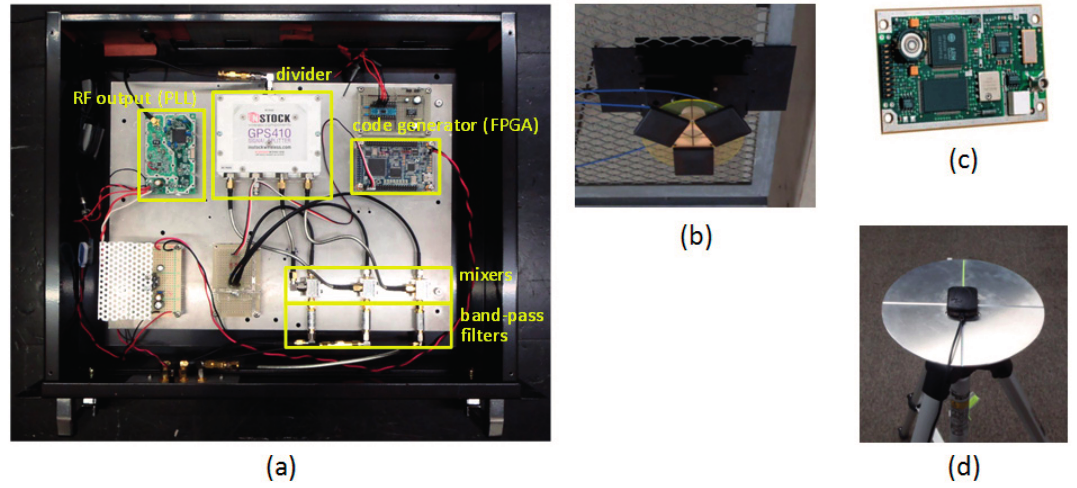
Figure 3. ( a ) Multi-channel pseudolite (three channels); ( b ) Three channel antenna array; ( c ) SuperStar II TM receiver module; ( d ) Receiver antenna on ground